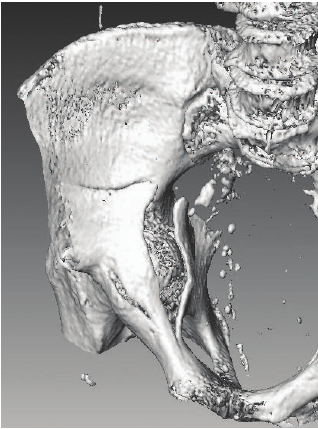
Figure 4: AP Pelvis X-ray showing displaced fractures of both acetabuli with intrapelvic protrusion of both femoral